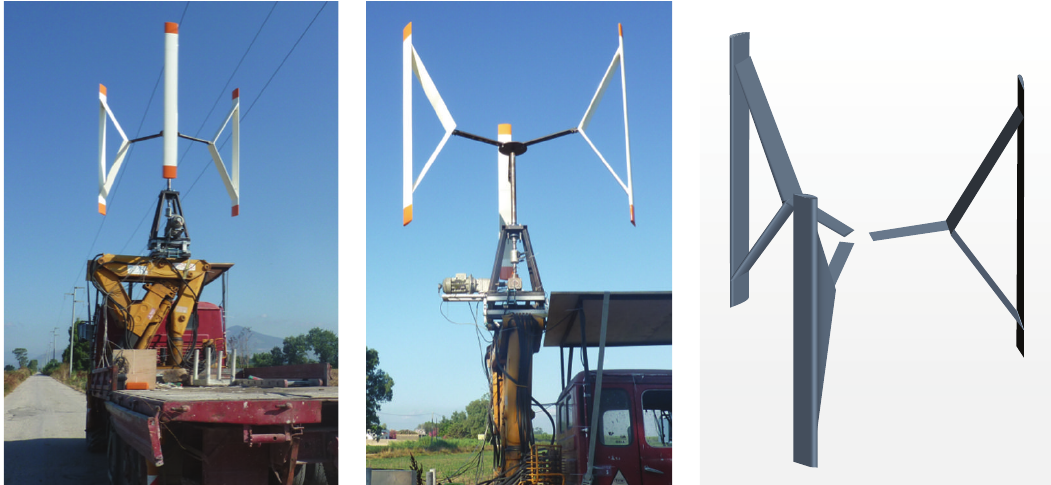
Figure 7: Real turbine during experiments performed in open field, along with the turbine geometric model used in the simulations.